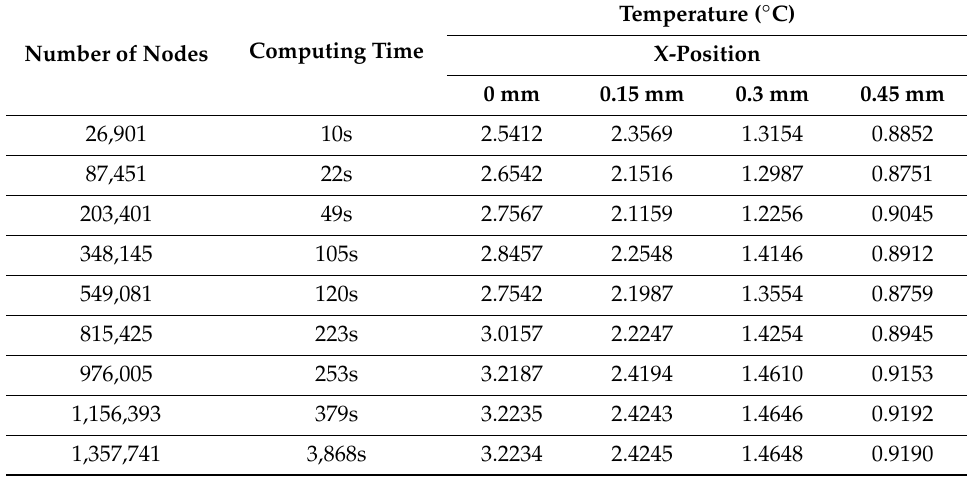
Table 4. Node dependency